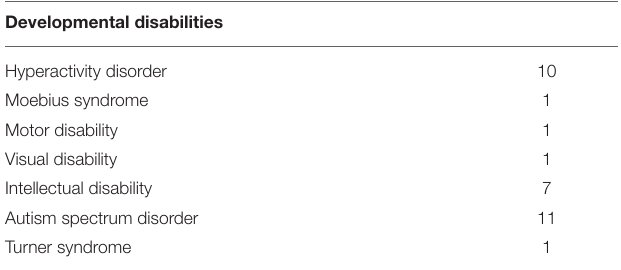
TABLE 1 | Children with developmental disabilities participants in the research de 2018a 2021.